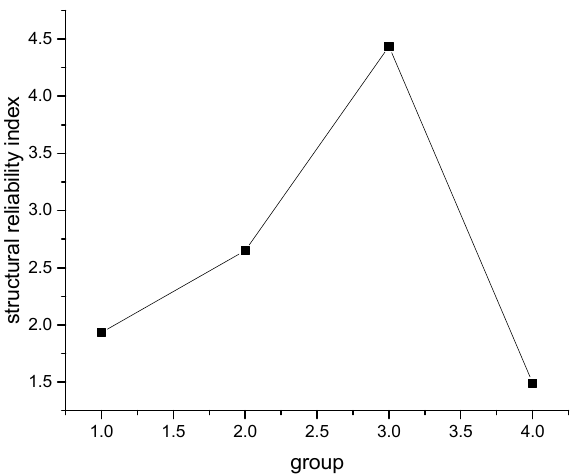
Figure 14. Reliability indices of the different representative paths when λ = 2.